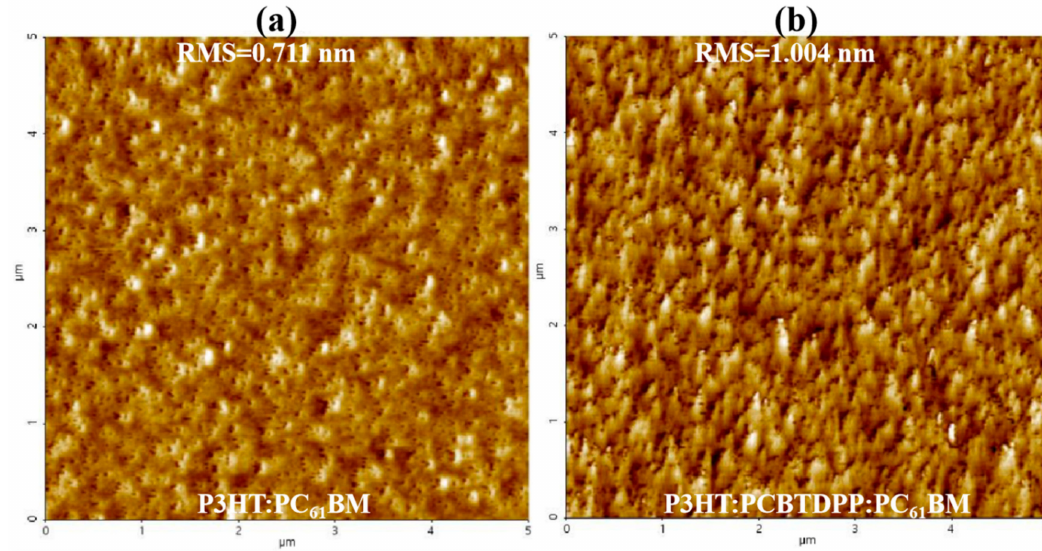
Figure 3. Atomic force microscope (AFM) topography images of the ( a ) binary and ( b ) ternary blend active layer coated atop ITO.